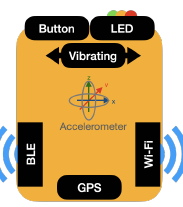
Figure 8. A Belt-Device